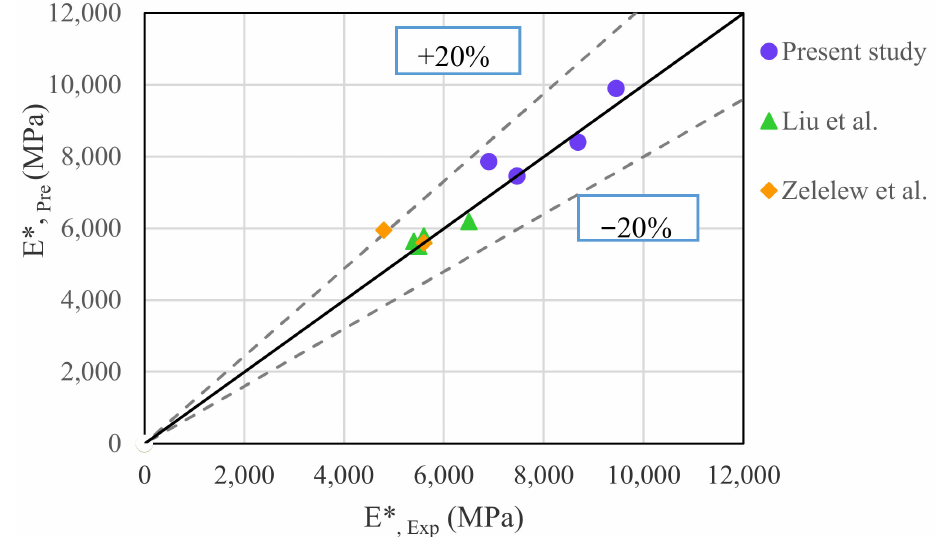
Figure 11. Comparison of the dynamic module results between the proposed model and the labora- tory results of other